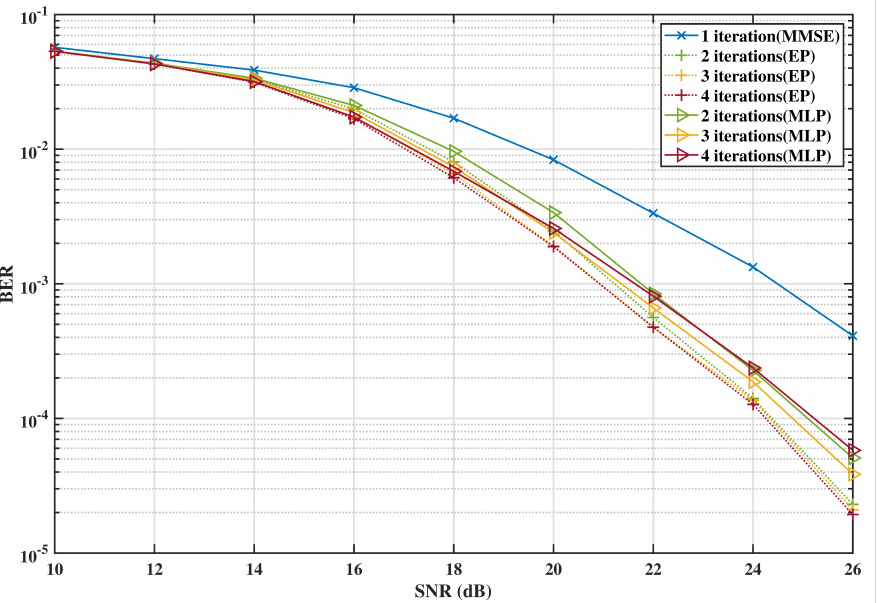
Figure 4. BER performance for the case of the correlated Rayleigh fading MIMO channel scenario scenarios with n = 4, m = 8, and 64-QAM